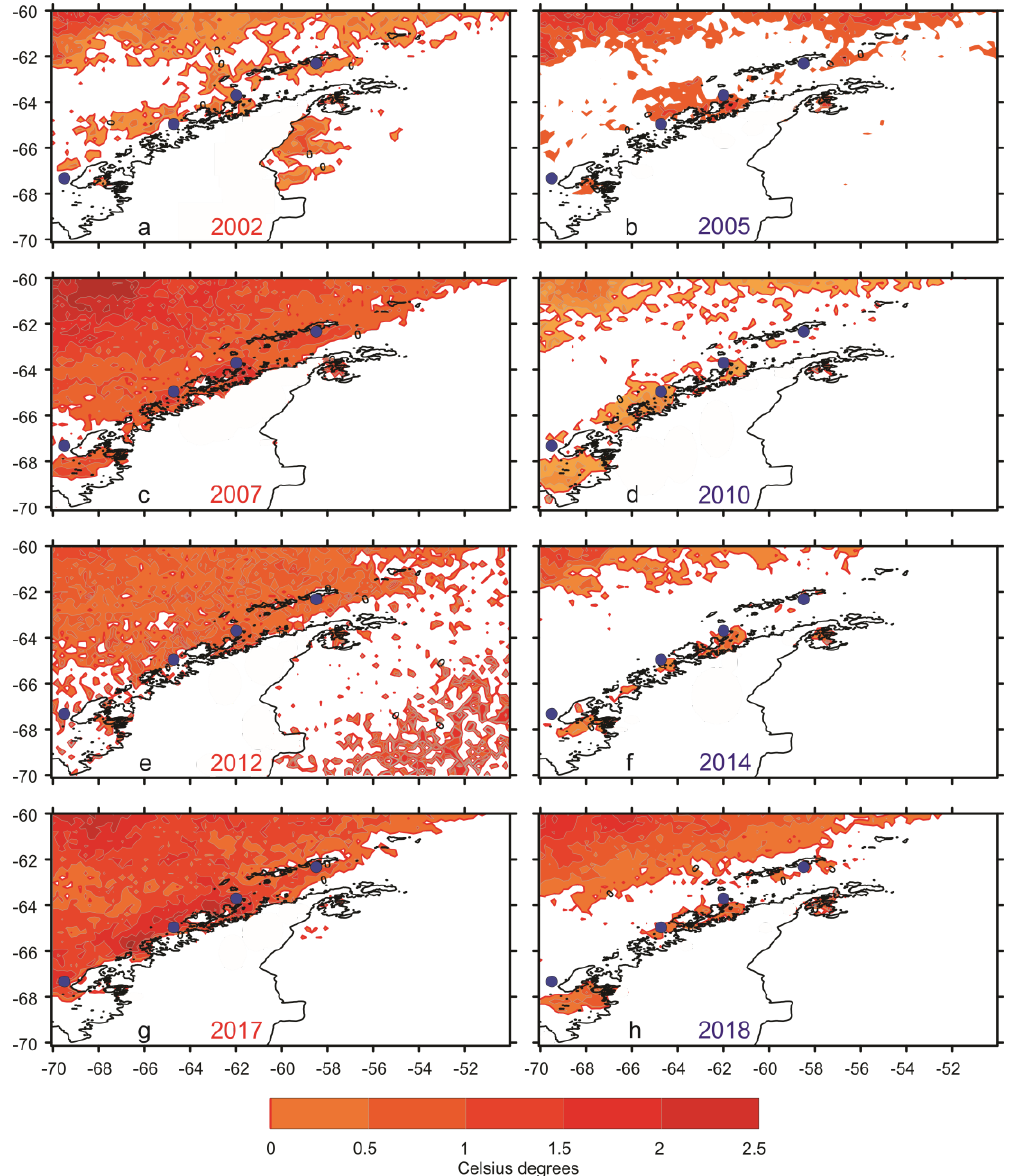
Figure 6. Location of the warm front at the WAP in the year with a warm ( a , c , e , g ) or cool ( b , d , f , h ) January.